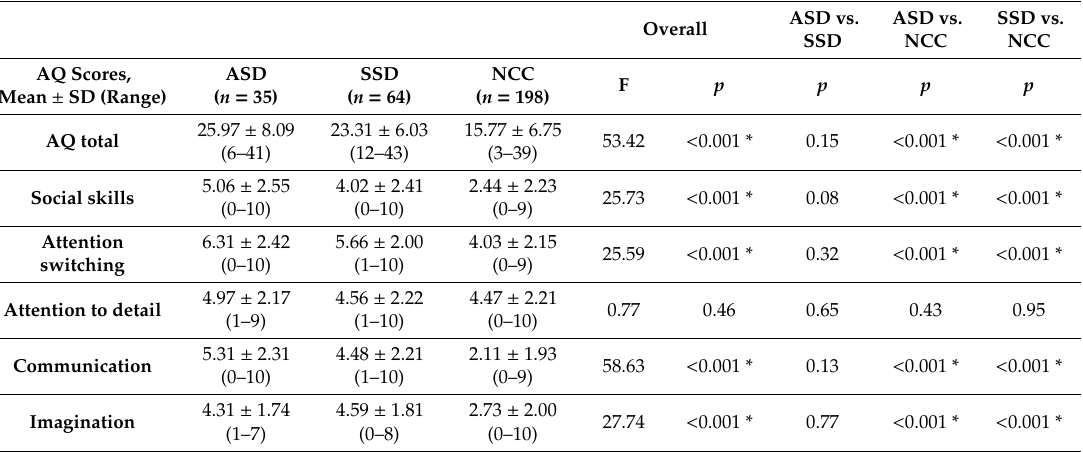
Table 3. Accuracy of AQ in discriminating ASD from SSD and NCC.